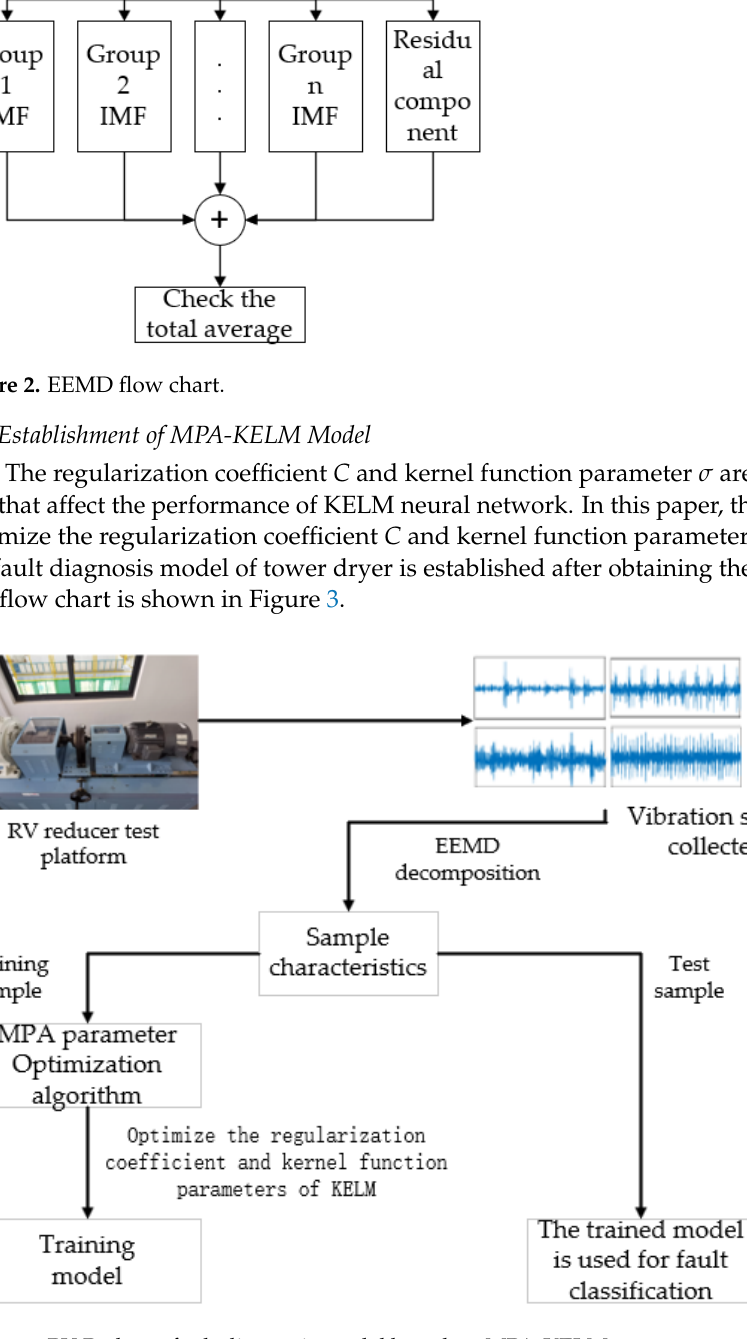
Figure 3. RV Reducer fault diagnosis model based on MPA-KELM.